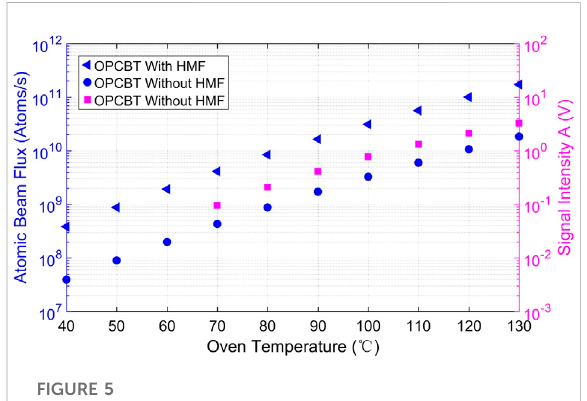
FIGURE 5 The calculated atomic beam fl ux of | m F = 0 > in OPCBT with HMF (blue triangles) and OPCBT without HMF (blue circles). The